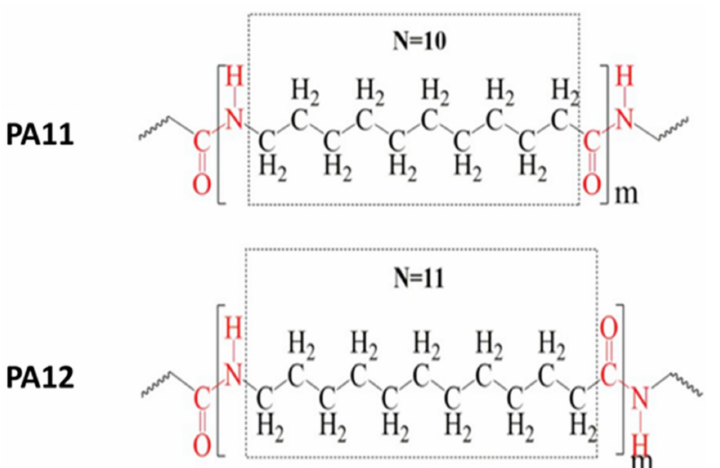
Figure 1. Chemical structure of PA11 and PA12 [12] (N: number of methylene groups between amide groups). Copyright 2020